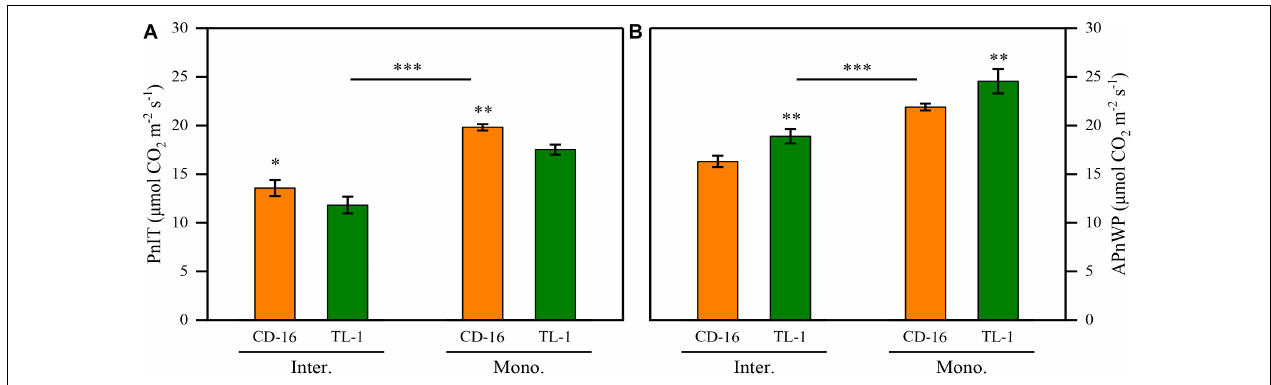
FIGURE 6 | Effects of different cultivars and planting patterns on the PnIT (A) and the APnWP (B) at R1 stage. The ∗ and ∗∗ indicate significant differences between CD-16 and TL-1 at the levels of p < 0.05 and p < 0.01, respectively. The ∗∗∗ on the black short line indicates extremely significant differences between intercropping and monocropping at the levels of p < 0.001. Data are average of three replicates. Error bars represent standard errors. Mono. and Inter. are the abbreviation of monoculture and strip intercropping, respectively.